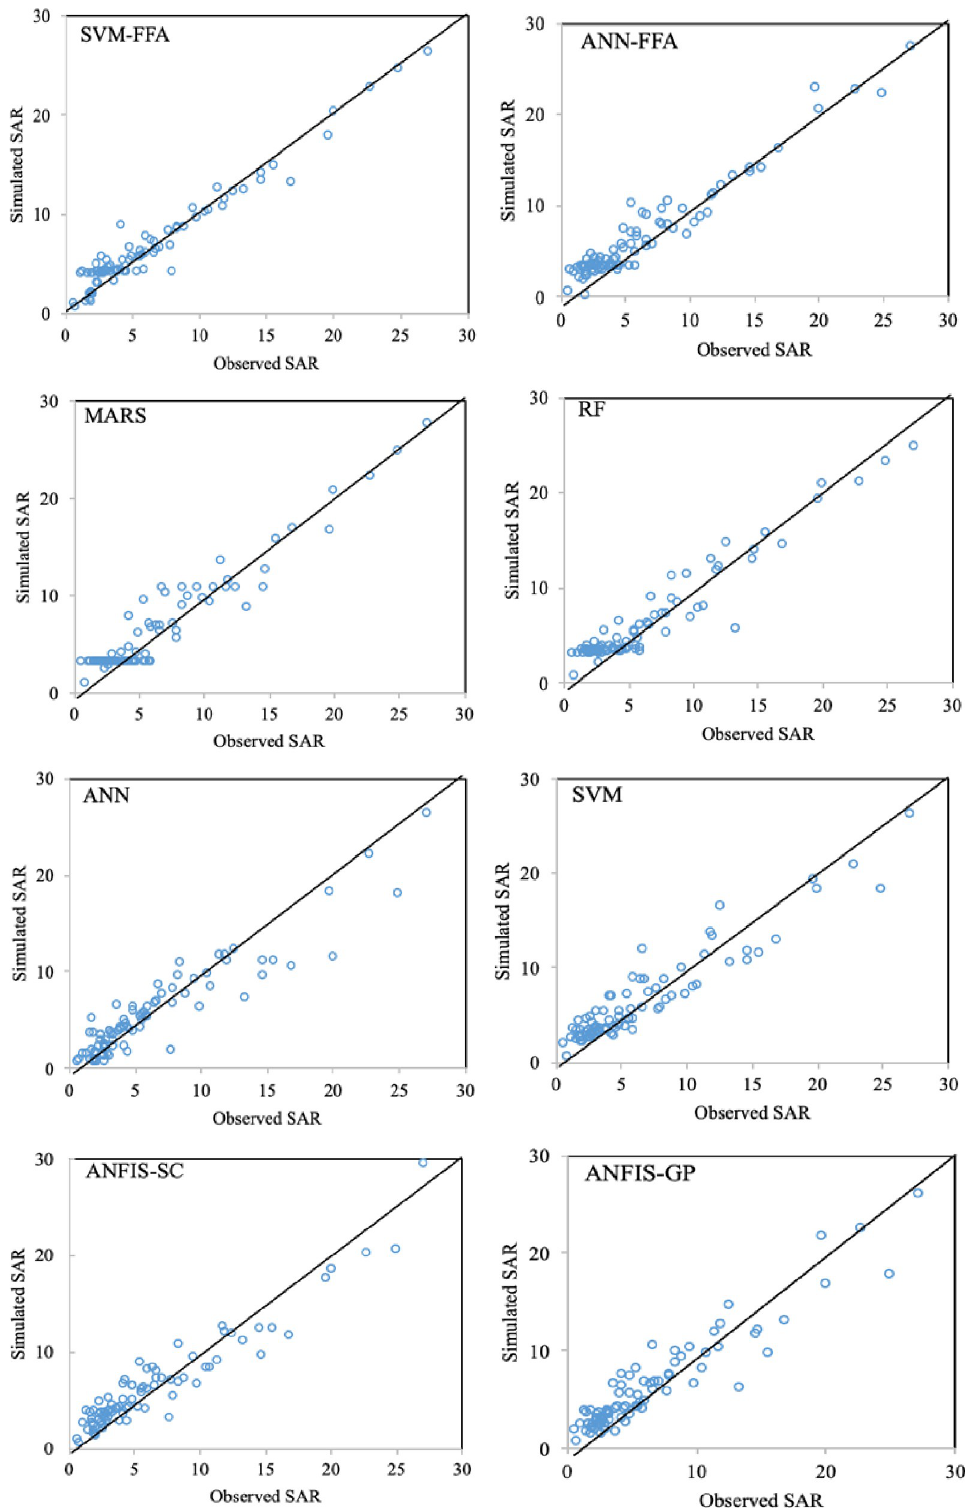
Fig 7. The scatterplots of the predicted SAR using the applied AI models.